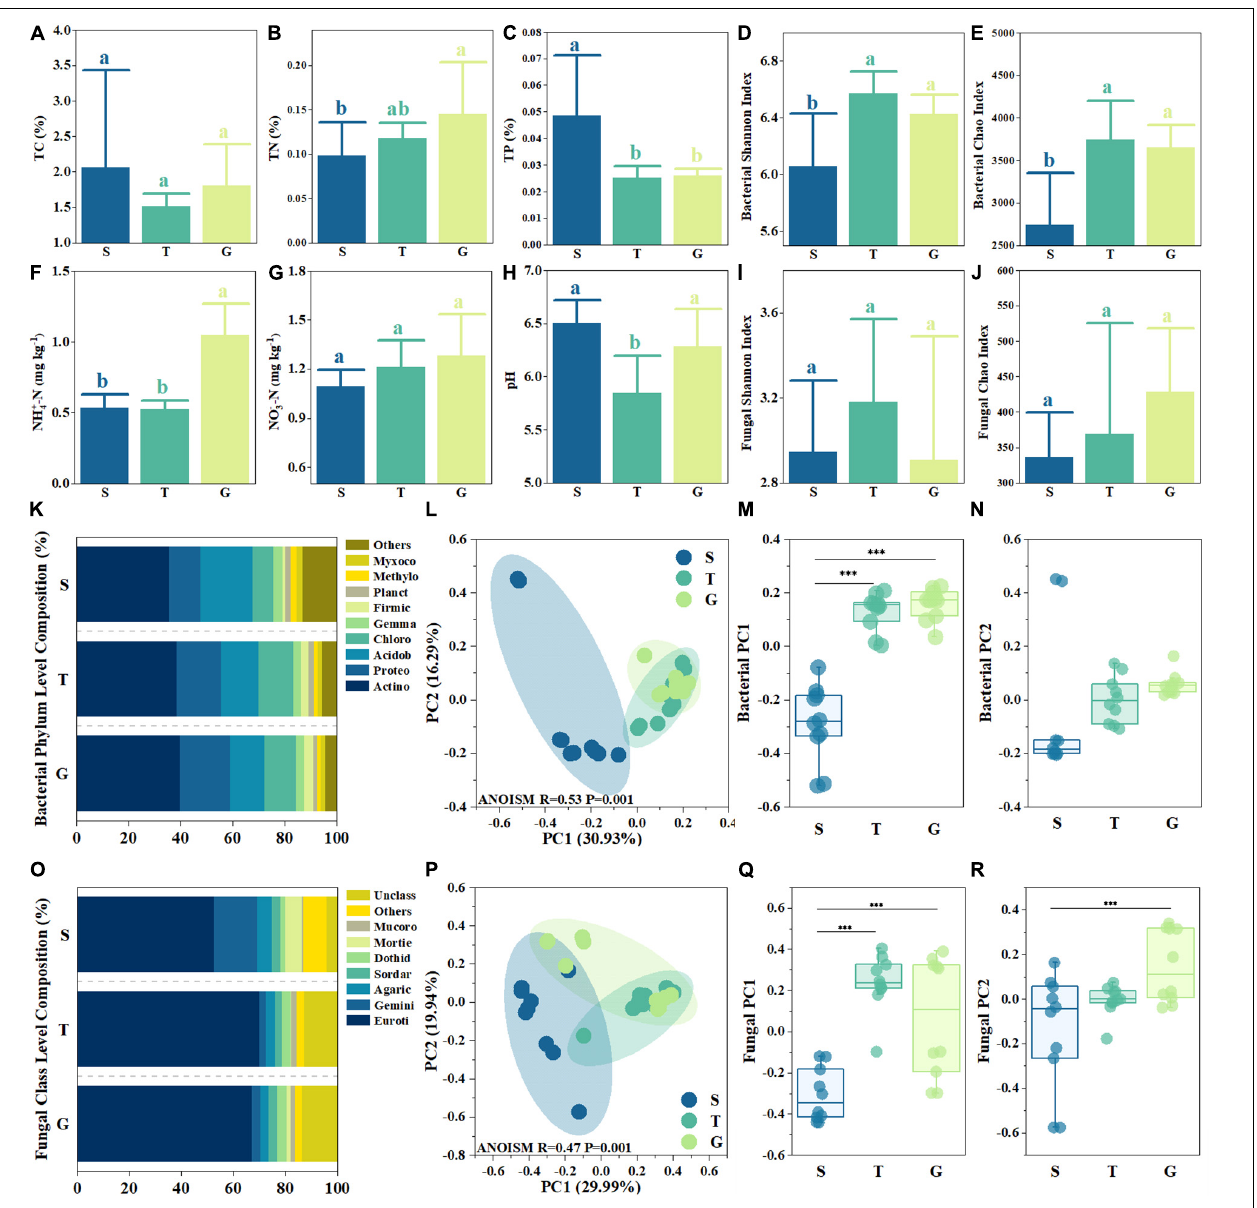
FIGURE 1 | Basic abiotic and biotic site properties. Shrubland (S), transitional (T), and Grass (G) in each sub-figures indicate shrub, transition, and grassland. Subfigures (A–J) depict soil total carbon (TC), total nitrogen (TN), total phosphorus (TP), ammonia content, nitrate content, pH, bacterial and fungal community Shannon index, and Chao index. The bars in the histogram indicate the average, and the error bars indicate standard deviation ( n = 10). The different letters inside subfigures (A–J) indicate significant differences between groups ( p < 0.05, one-way ANOVA Tukey’s test). (K,O) depict the bacterial phylum composition and fungal class composition, respectively, with six letter abbreviations adopted for bacterial phylum and fungal class names. (L,P) depict principal coordinates analysis (PcoA) analysis for bacterial community and fungal community at the OUT level, respectively. The ∗∗∗ in subfigures (M,N,Q,R) indicate significant differences between groups ( p < 0.05, one-way ANOVA Tamhaney’s T2